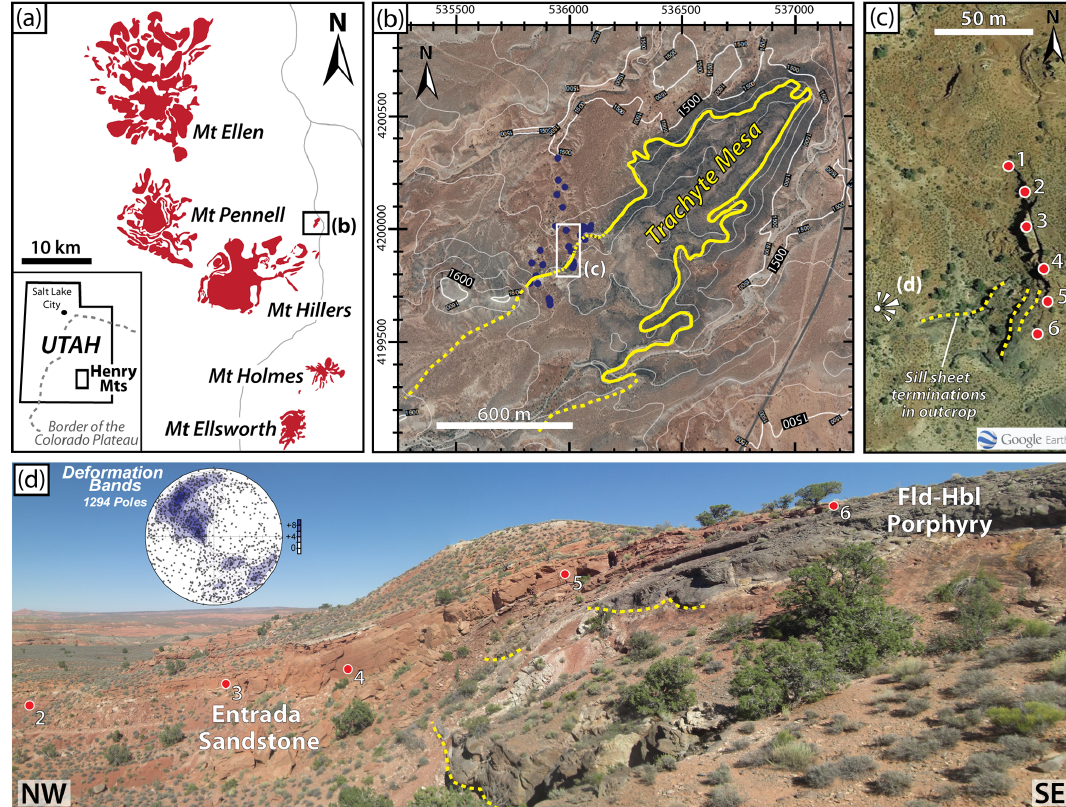
Figure 1. Geological setting and study area. (a) Simplified maps showing location of the Henry Mountains intrusive complex and the Trachyte Mesa intrusion. Intrusion areas adapted from Morgan et al. (2008). (b) Contoured (20m intervals) aerial image (Source data: National Agricultural Imagery Program, https://gis.utah.gov/data/aerial-photography/, last access: 28 December 2020) of the Trachyte Mesa area showing the intrusion outline (yellow) and study area. Dashed lines in the SW depict the sub-surface extent of the intrusion, as defined by Wetmore et al. (2009) from magnetic resistivity data. Blue dots show field localities visited as part of wider reconnaissance studies (Wilson et al., 2016). (c) Satellite photograph (© Google Earth) of the study area (NW margin of the Trachyte Mesa intrusion). Structural stations for fracture studies indicated by numbered red dots. Yellow dashed lines show outcrop exposure of sill sheet terminations. (d) Field photograph showing monoclinal geometry of the NW intrusion margin. Note blocky, red Entrada Sandstone units concordant with the underlying intrusion top surface, and stacked intrusive sheets below (sheet terminations highlighted in yellow). Structural Stations 2–6 are indicated (red dots). Viewpoint location shown in (c) . Contoured equal-area stereoplot shows poles to planes for deformation bands measured across the NW-margin of the Trachyte Mesa intrusion (from Wilson et al.,